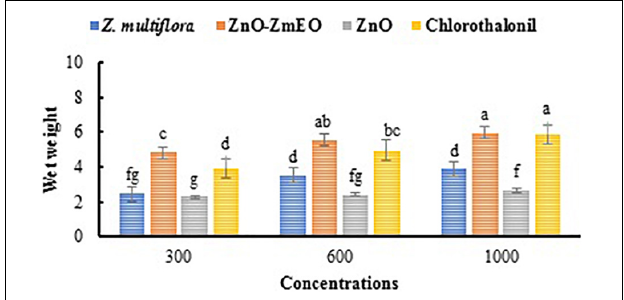
FIGURE 8 | Comparison of mean dry weight of tomato plants treated by different concentrations of the ZnO, pure Z. multiflora EO, ZnO-ZmEO, and